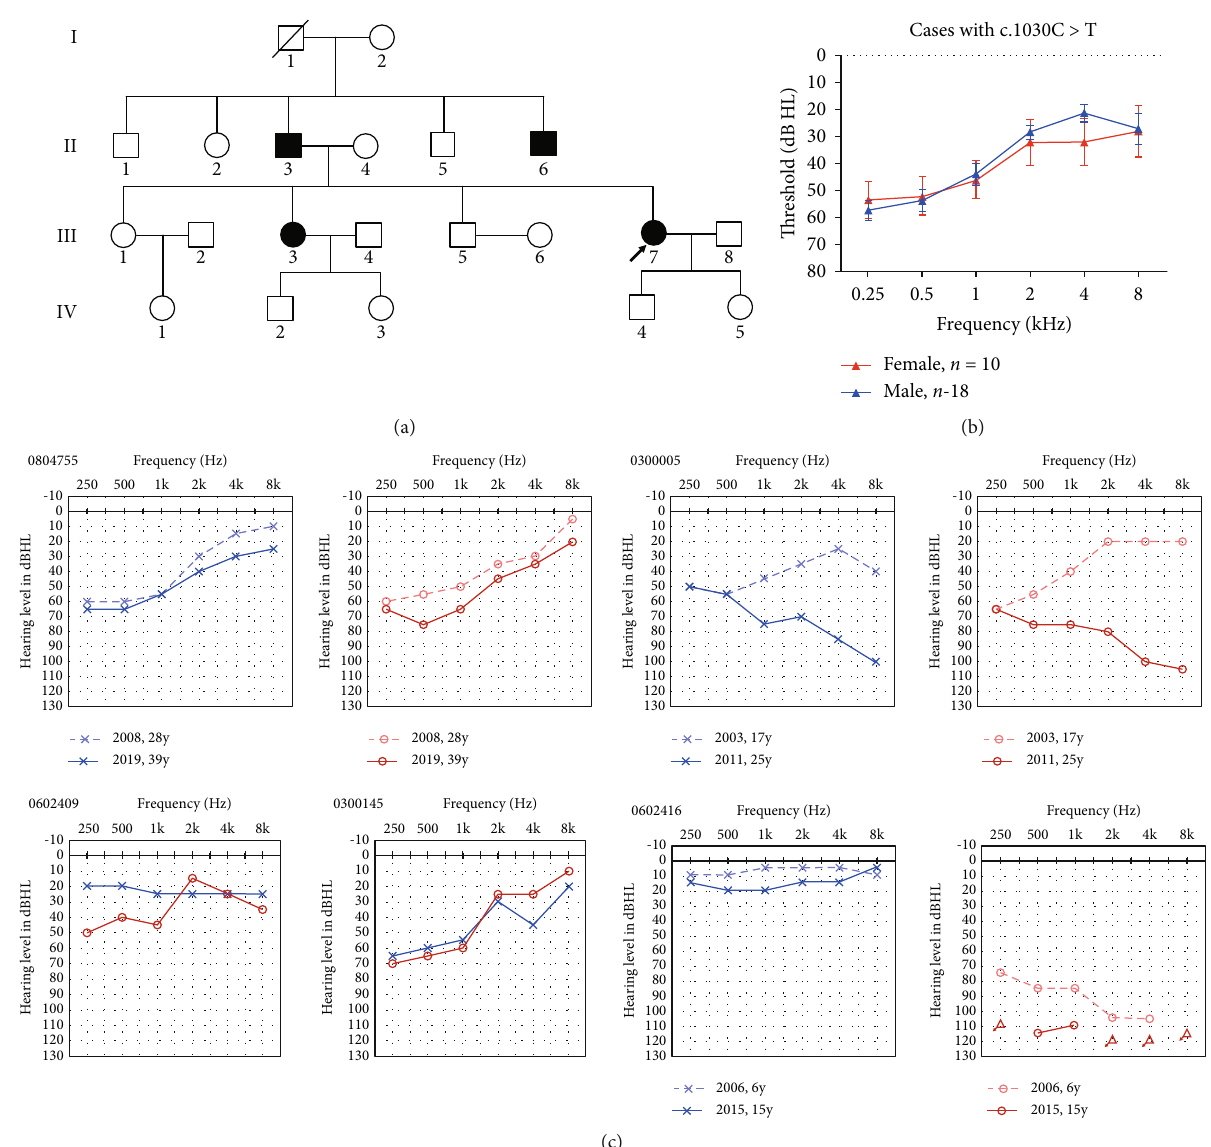
Figure 3: Family trees and audiological characteristics of the fi ve female cases. (a) Family trees of the family 0804755. (b) Mean hearing threshold of the cases with the AIFM1 c.1030C > T (p.Leu344Phe) variation. (c) Audiograms of the fi ve female a ff ected cases. Symbols “ o ” and “ x ” denote air conduction pure tone thresholds at di ff erent frequencies in the right and left ears. dB: decibels; Hz: Hertz. The dashed line represents the audiograms detected in the fi rst time, while the solid lines were the latest audiological examinations. y: years